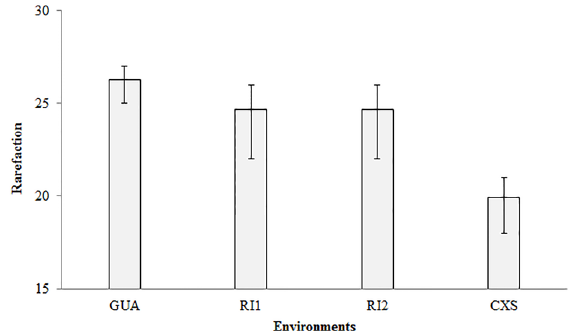
Figure 1 - Observed (S(Mao Tau)) and estimated (Chao1) ant richness in the Permanent Preservation Area in the Foz do Chapecó hydroelectric power plant lake area in Guatambu (GUA) and Caxambu do Sul (CXS) in Santa Catarina, and in Rio de Índios (RI1 and RI2) in Rio Grande do Sul (January 2016).